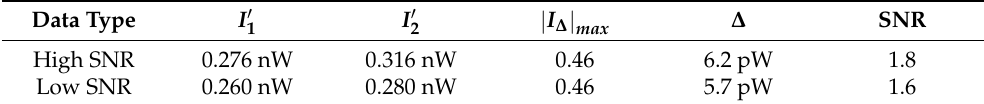
Table 2. Estimation of the SNR for two sets of measured data.